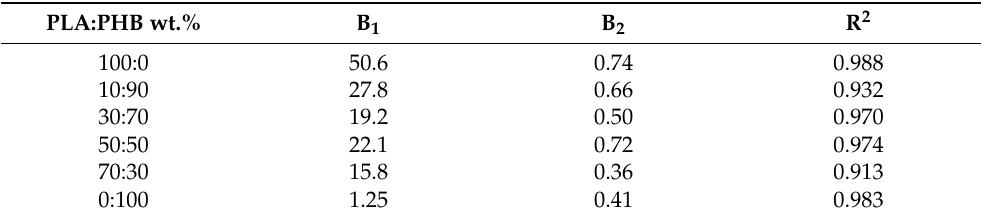
Table 1. The water isotherm constants calculated from linear regression of Equation (4) with corre- sponding coefficients of